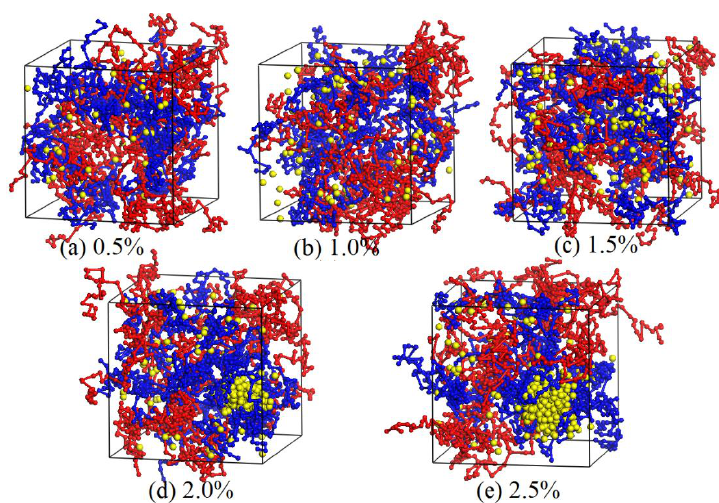
Figure 6. Equilibrated morphologies of 10% PVA/10% PAM blended hydrogels with different nano-silica contents: ( a ) 0.5%; ( b ) 1.0%; ( c ) 1.5%; ( d ) 2.0%; and ( e ) 2.5%.